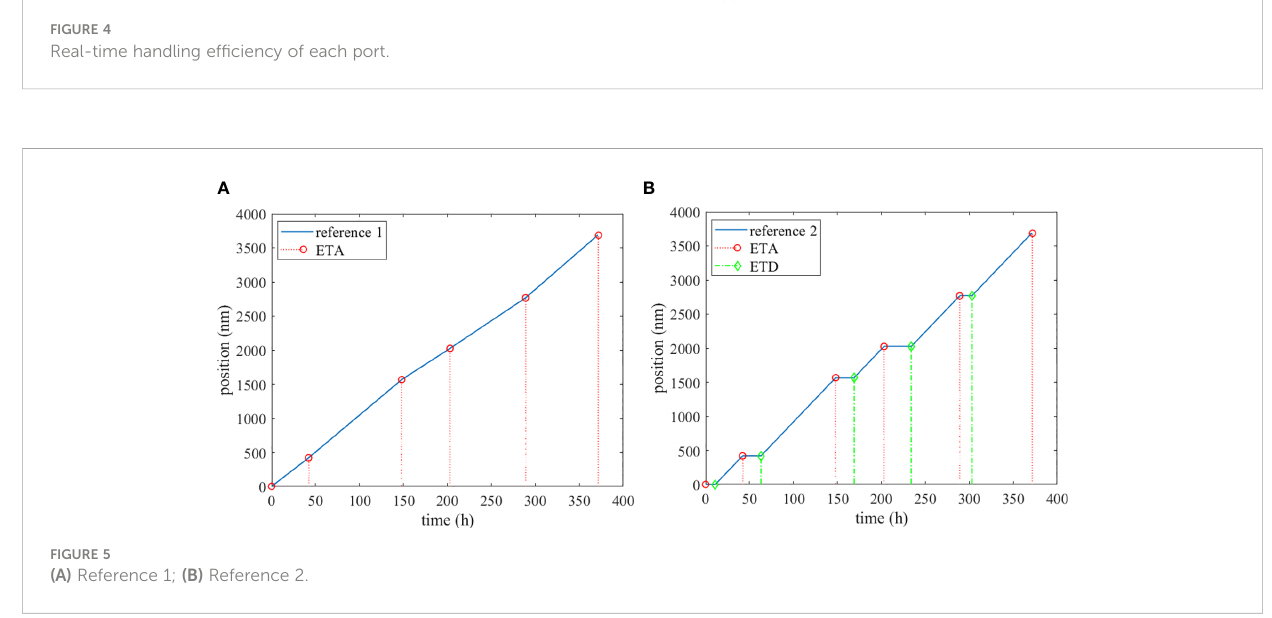
FIGURE 5 (A) Reference 1; (B) Reference 2.